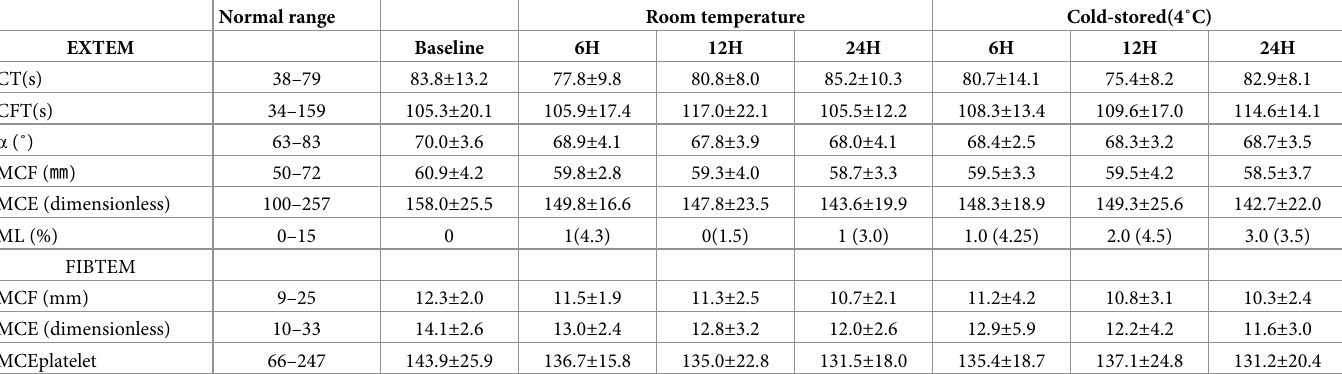
Table 3. Results of whole blood coagulation measured by rotational thromboelastometry during storage (n = 10). Normal